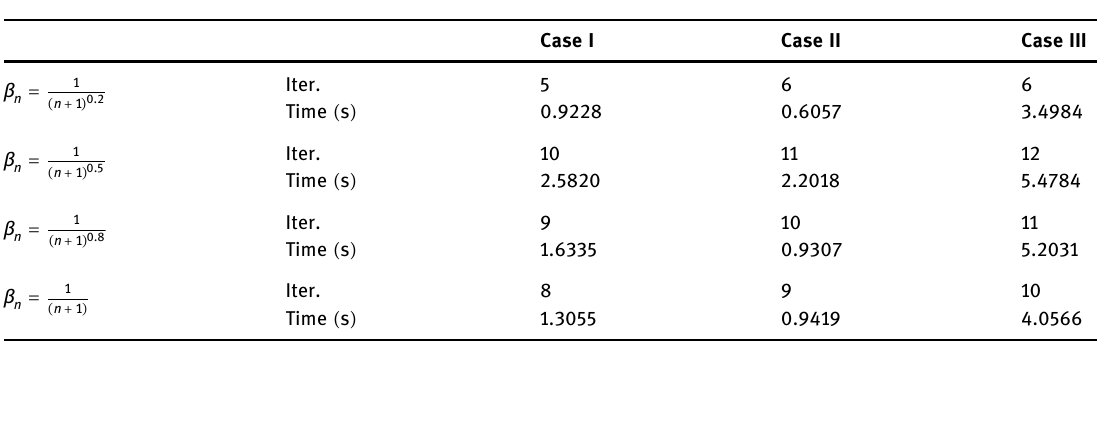
Table 3: Computation result for Example 4.2, Experiment 1